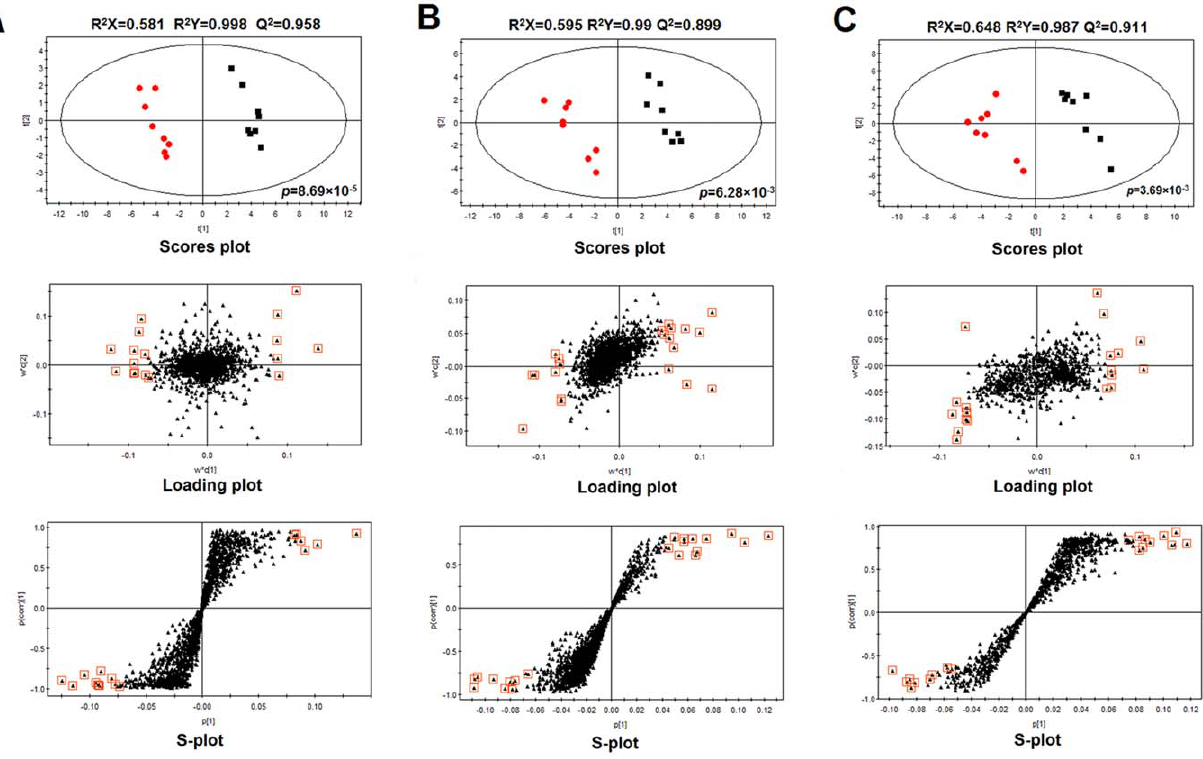
Figure 3. PLS-DA scores plot (top panel), loading plot (middle panel) and S-plot (bottom panel) of the UHPLC/TOF-MS spectral from control group (box) and hypothyroid group (dot). ( A : control group vs MMI group; B : control group vs PTU group; C : control group vs thyroidectomy-induced hypothyroid group).